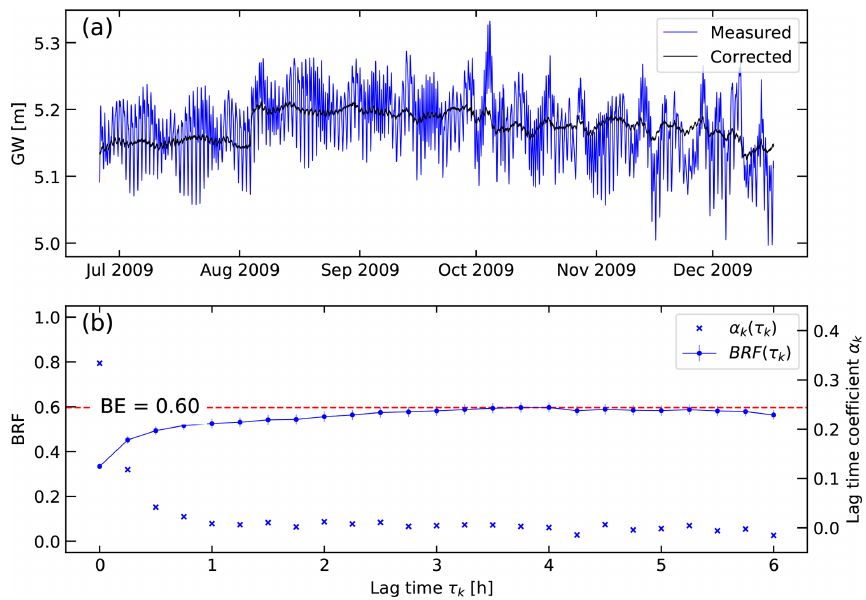
Figure 6. (a) Borehole pressure head (GW) measured and corrected for barometric and Earth tide influences. (b) Barometric response function (BRF) and BE BRF calculated using the records shown in Fig. 2 and the approach summarised in Appendix B.